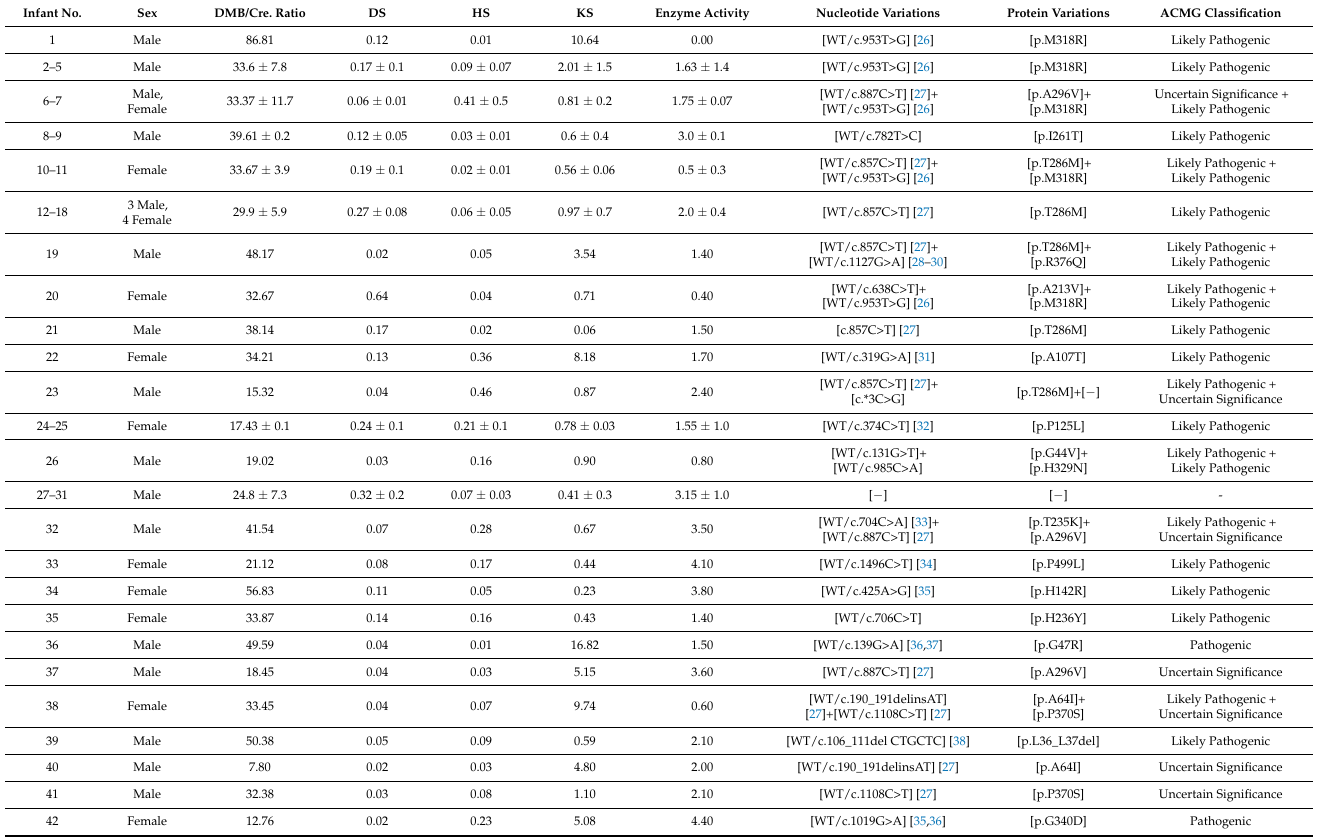
Table 3. Biochemistry tests, enzyme activity, and mutations of Galactosamine (N-acetyl)-6-sulfatase (GALNS) gene in suspected MPS IVA